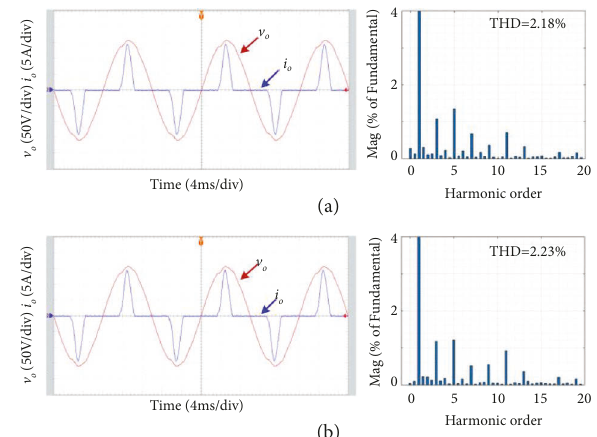
Figure 21: Steady-state waveforms with different L